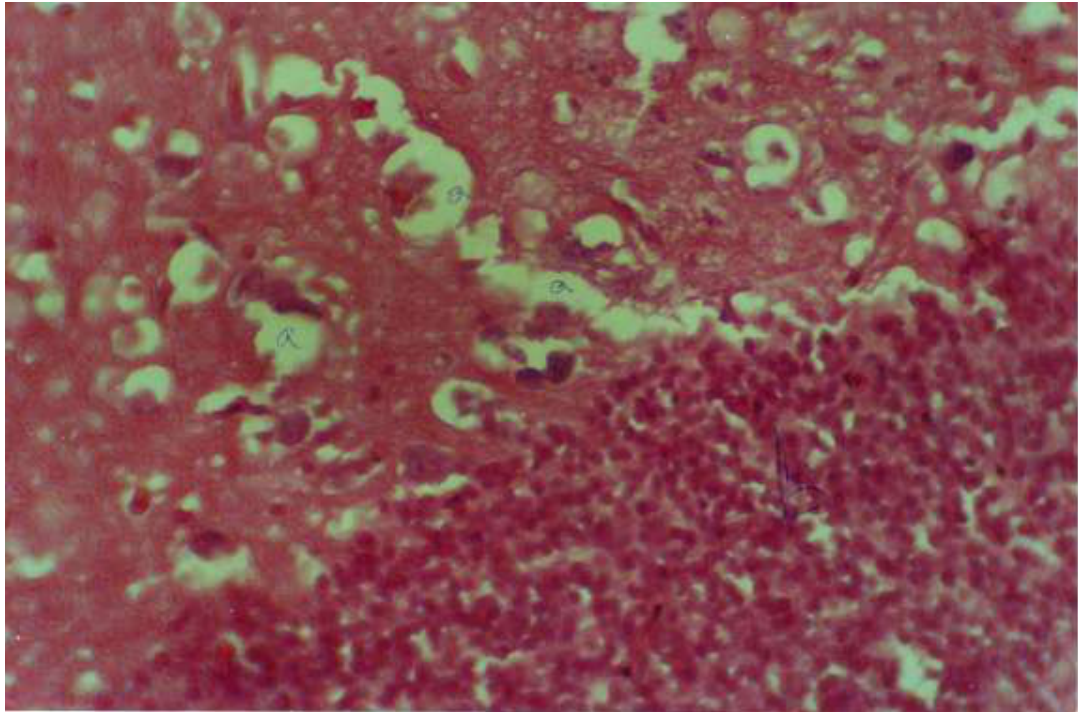
Figure ( 1 ):Brain of Mice , 2 nd group see:(a) Neuron necrosis ( b ) Cuffing lymphocytes ( X40 H& E stain